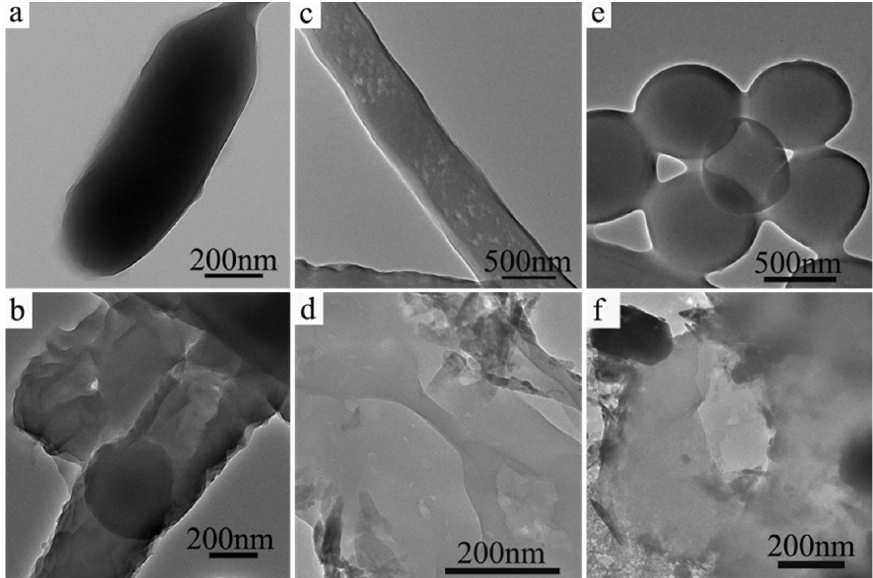
Figure 8. TEM images of normal E. coli ( a ), P. aeruginosa ( c ), S. aureus ( e ), and E. coli ( b ), P. aeruginosa ( d ) and S. aureus ( f ) treated with CuO@Ag nanosheets.